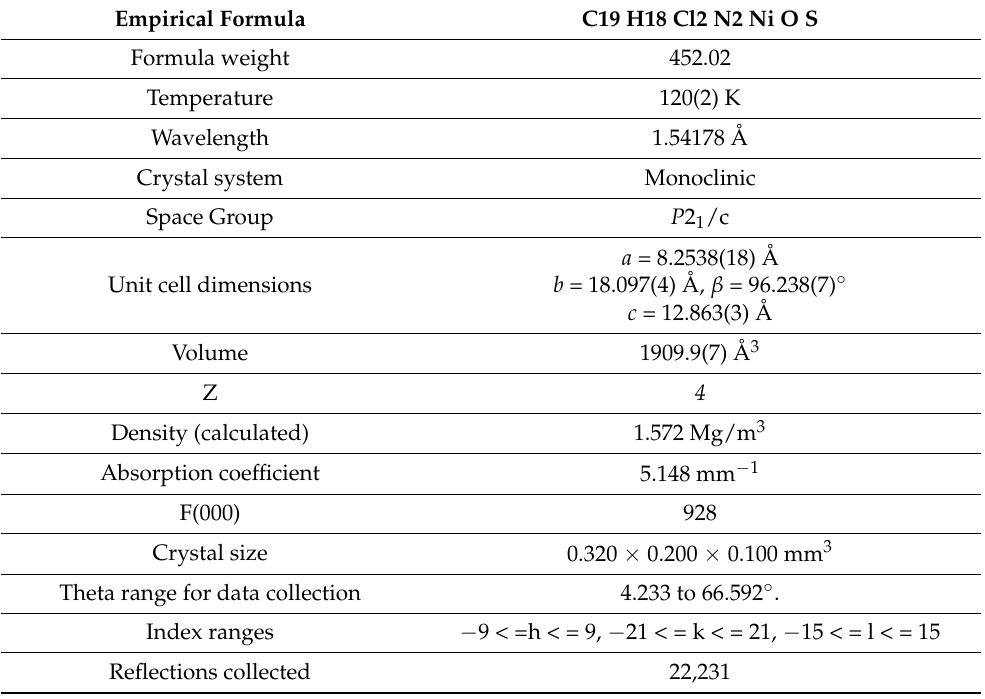
Table 3. Crystal data and structure refinement details for complex 2